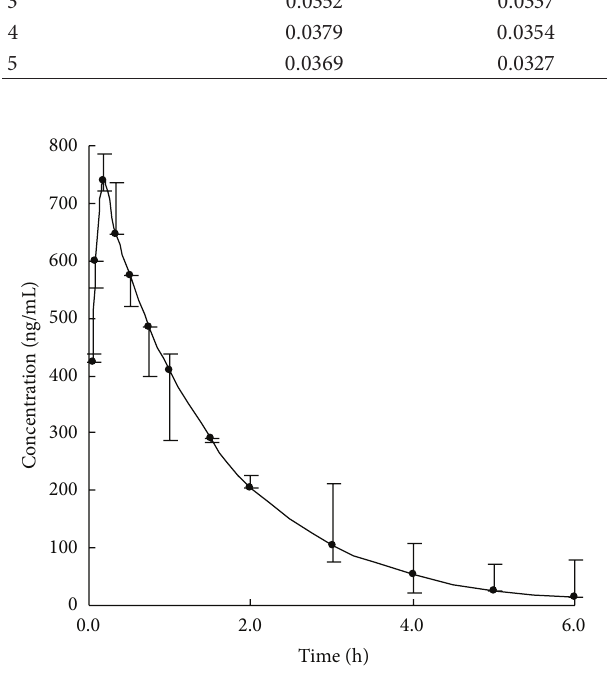
Figure 2: Mean plasma concentration-time profile of aesculin after administration of Cortex fraxini extract in rats ( 𝑛 = 6